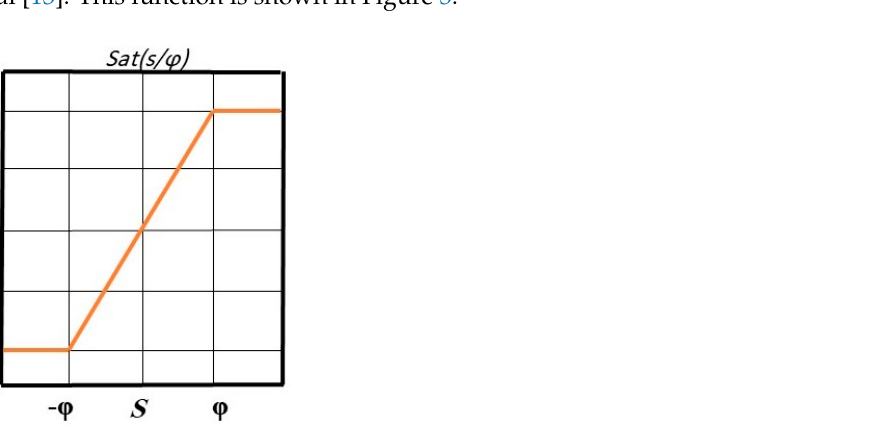
Figure 3. Saturation function. The horizontal axis is the angle and the vertical axis is the saturation function.